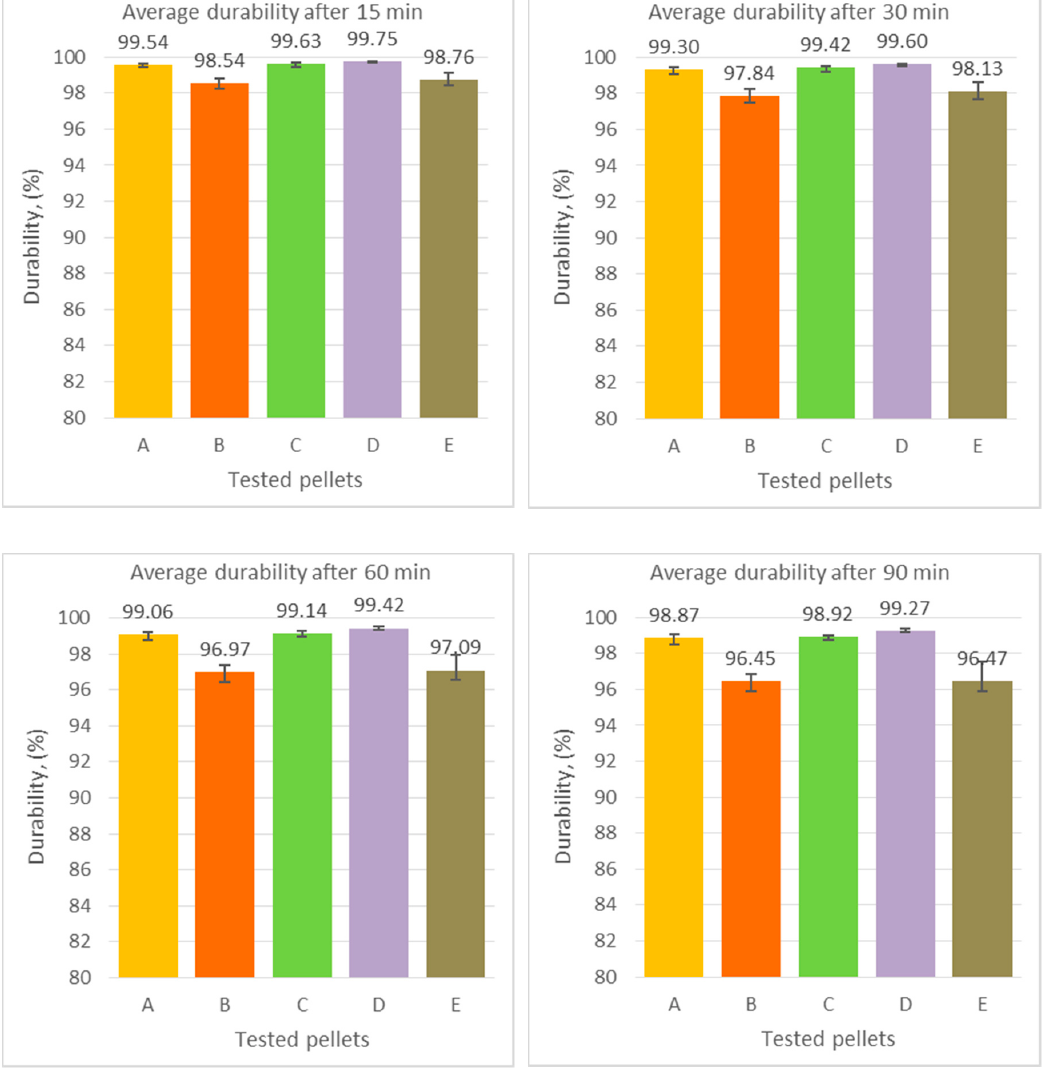
Figure 6. Results of durability of tested pellets in lateral vibration tests for different duration timing (own study).